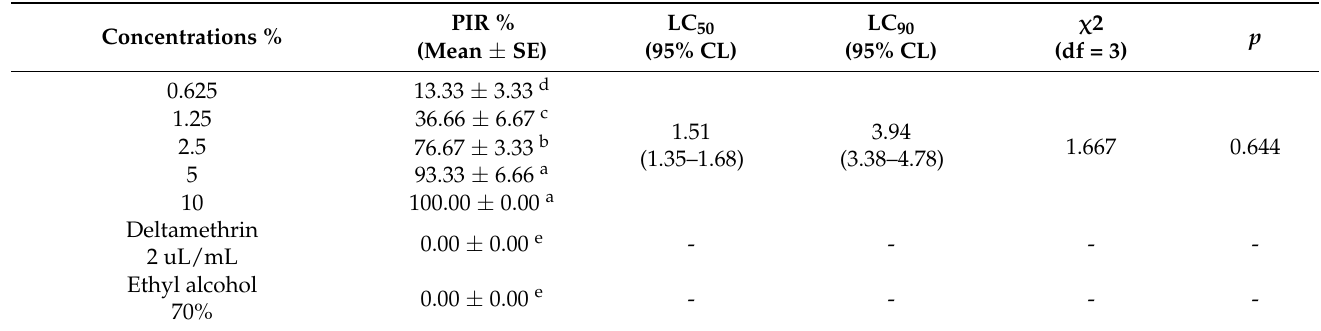
Table 6. Percentage inhibition rate (PIR) of Lavandula stoechas against housefly pupae in contact toxicity